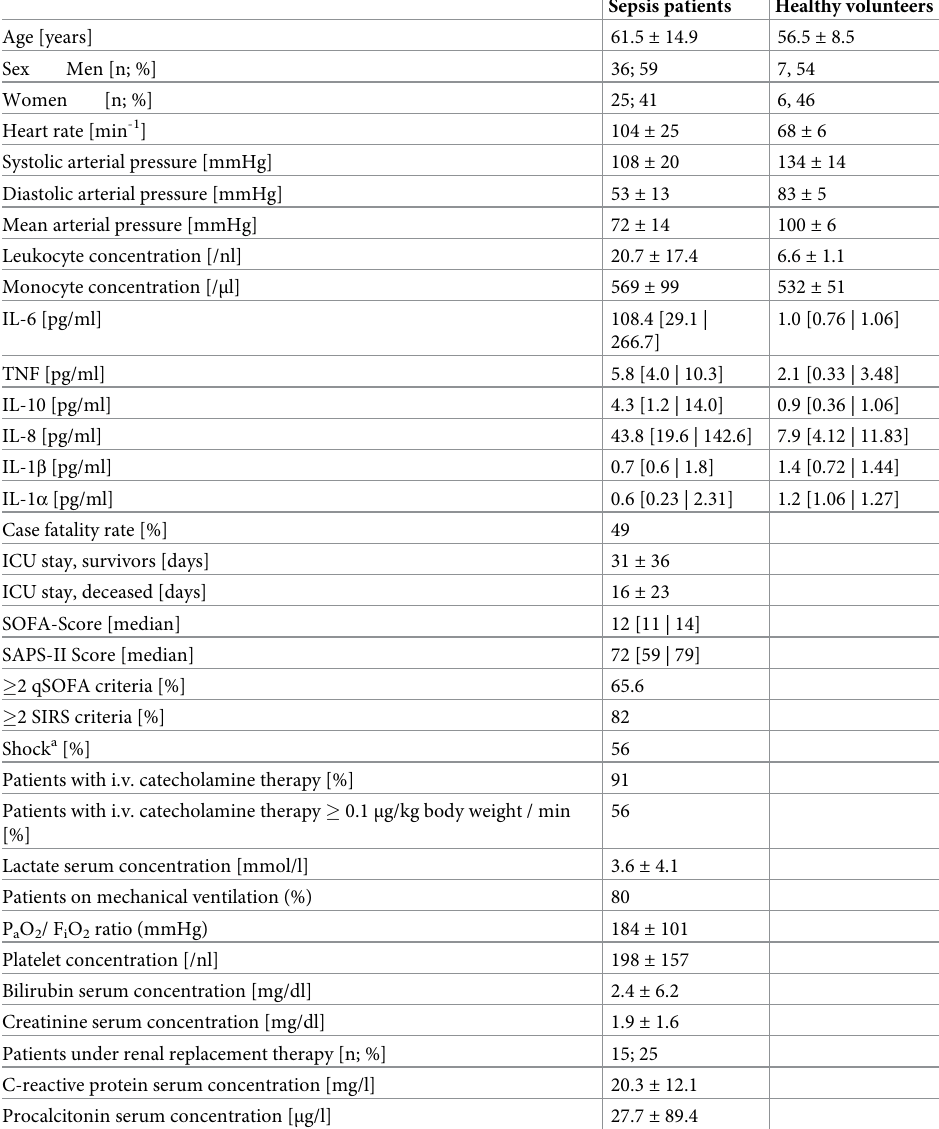
Table 1. Characteristics of sepsis patients and age-matched healthy